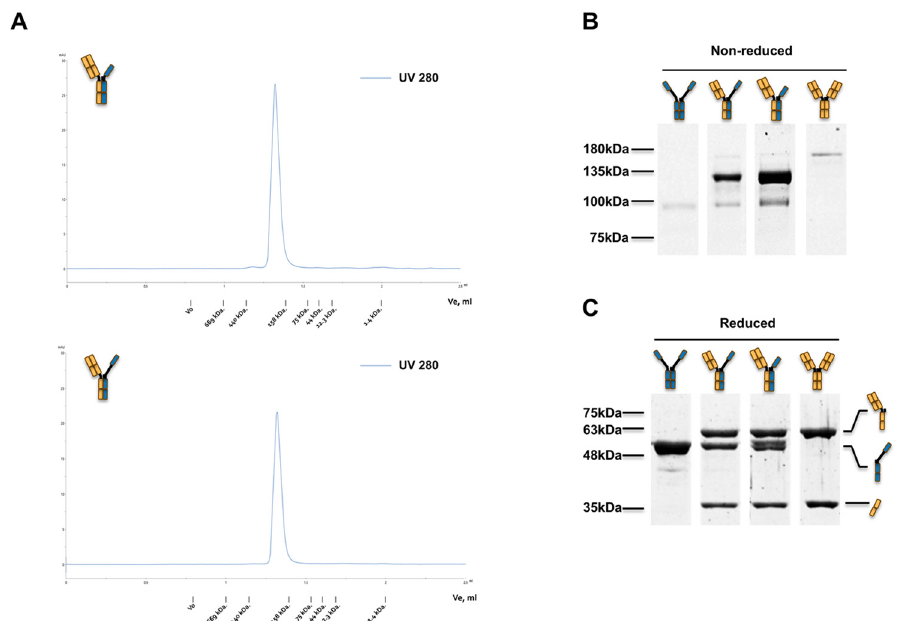
Figure 2. Analysis of the expressed mCD3E × mEGFR TbsAbs. ( A ) Size exclusion chromatography (SEC) analysis of TbsAb.long and TbsAb.short proteins. Ten µL of each respective sample (TbsAb.long and TbsAb.short), at 0.5 mg/mL were eluted by DPBS buffer at a flow rate of 50 µL·min − 1 . ( B , C ) SDS-PAGE analysis of TbsAb.long and TbsAb.short proteins under non-reducing and reducing conditions, respectively.